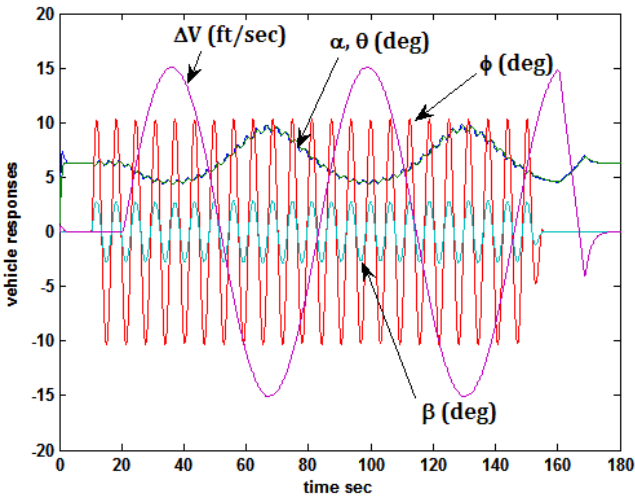
Figure 7. Vehicle responses for Task 1.